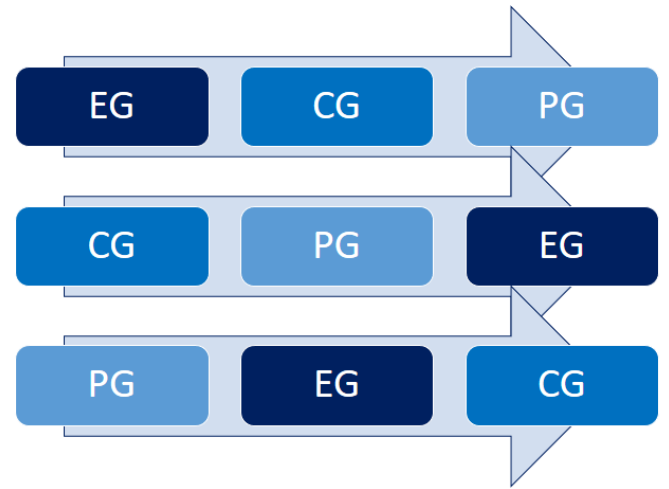
Figure 3. Intervention sequences of the crossover